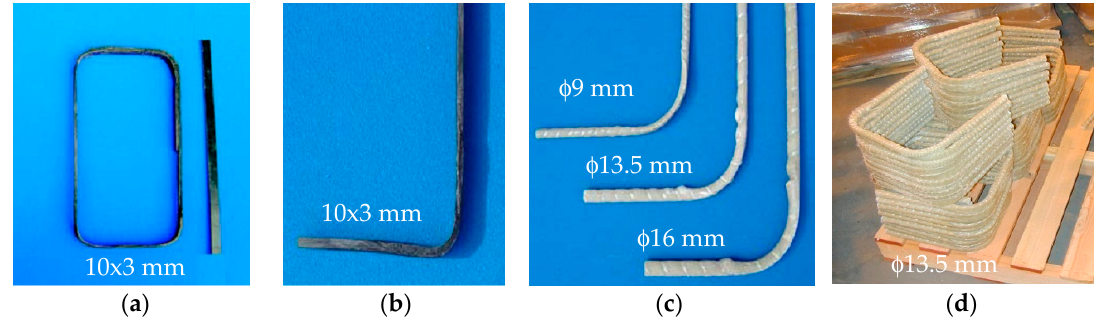
Figure 2. Commercially available curved fiber-reinforced polymer (FRP) reinforcements: ( a ) thermoplastic FRP stirrup; ( b ) J-hook FRP strip; ( c ) pre-bent FRP bar; and ( d ) U-shaped FRP bar.